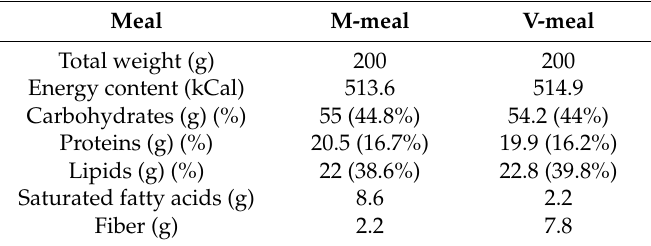
Table 2. Composition of the test meals.